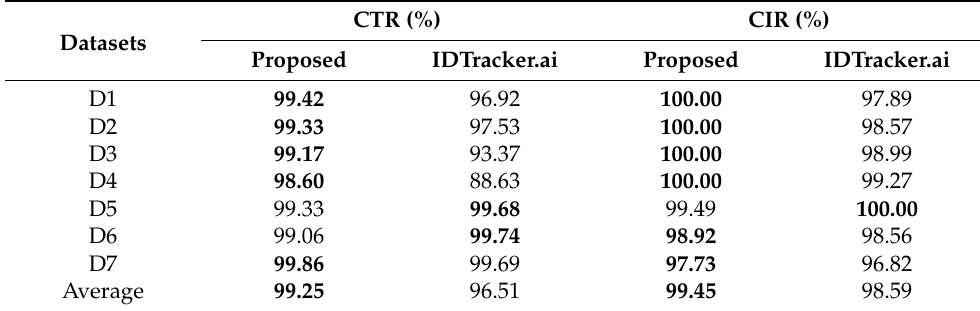
Table 4. Comparison results with IDTracker.ai (The best results are presented in bold font).